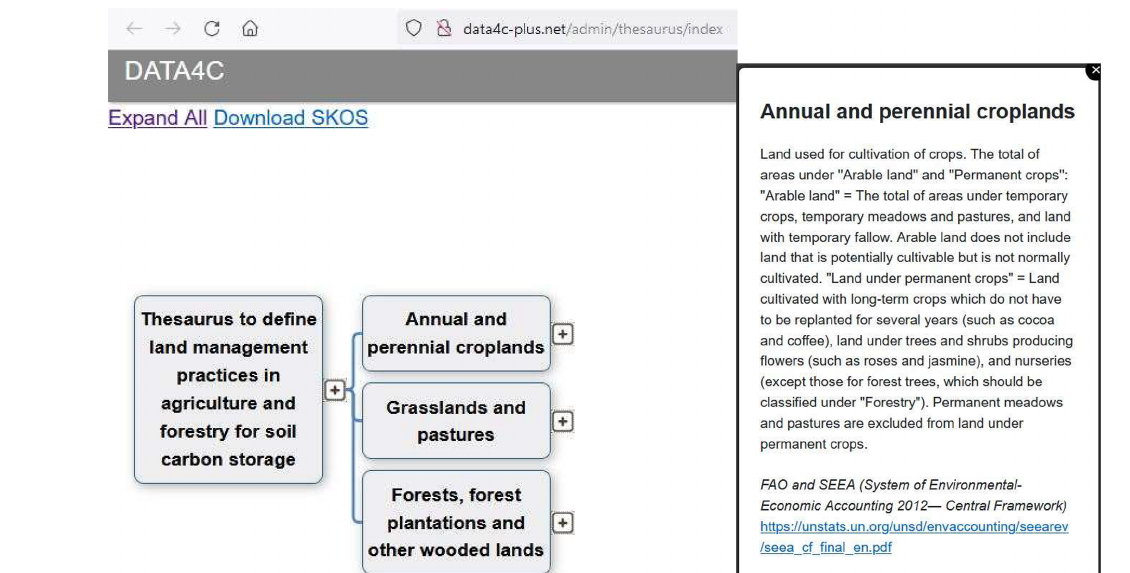
Figure 2. Browsing hierarchical tree and definition in the DATA4C + thesaurus (http://data4c-plus.net/admin/thesaurus/index, last access: 24 March